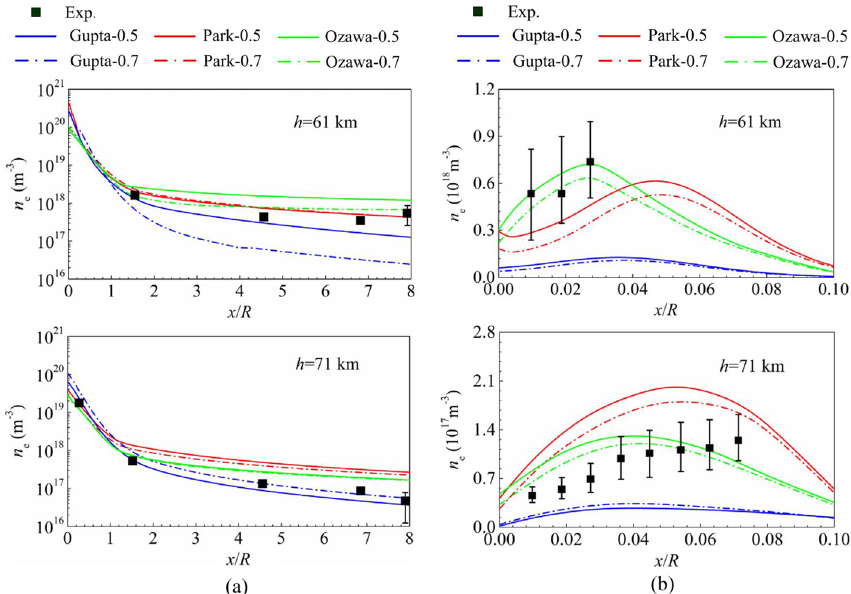
Fig. 9 Electron number density of BSUV-II [85]. ( a ) Peak electron number density along the surface and ( b ) electron number density at the location of the electrostatic probe rake